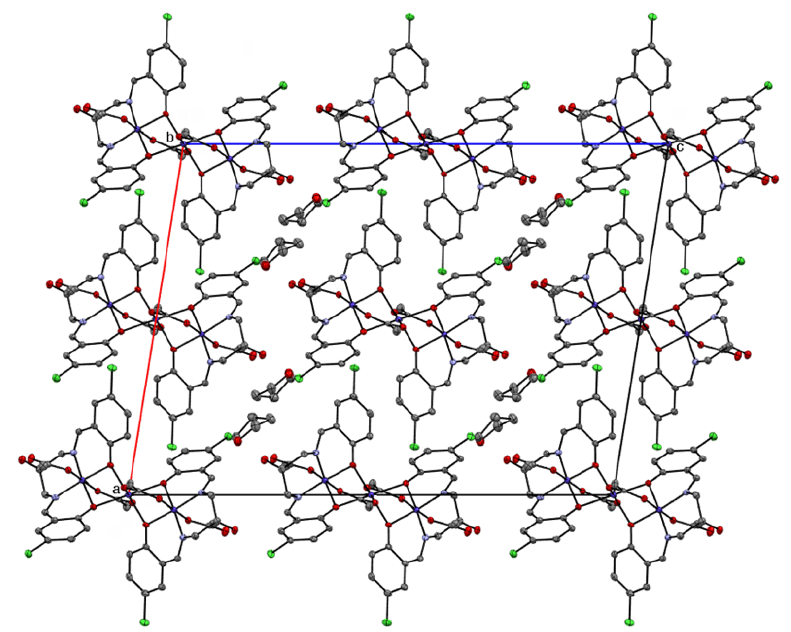
Figure 6. Packing diagram of [Co 3 (Hclsalpr) 2 (CH 3 COO) 4 ]·8THF. The hydrogen atoms have been omitted for clarity.